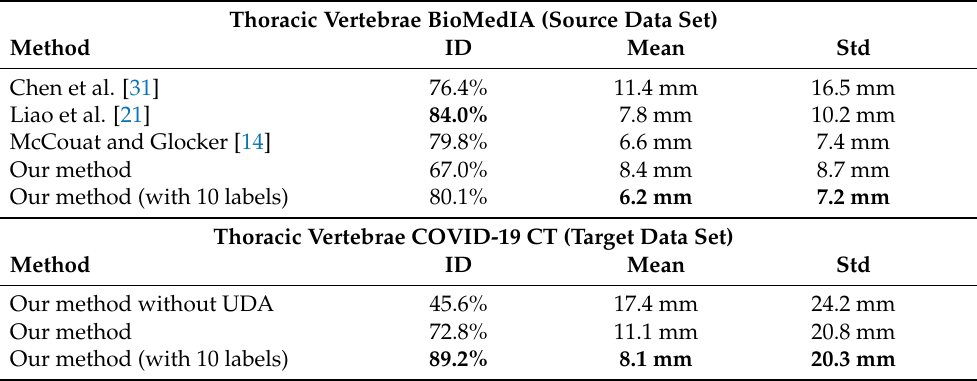
Table 3. Detection result per vertebra with the best score for each metric and data set in bold. The upper part of the table displays the results on thoracic scans of the source data set, the lower part the results on the target data set. The column “ID” gives the identification rate, column “Mean” reports the average distance to the ground truth centroid in mm and column “Std” gives the standard deviation in mm. Thoracic Vertebrae BioMedIA (Source Data